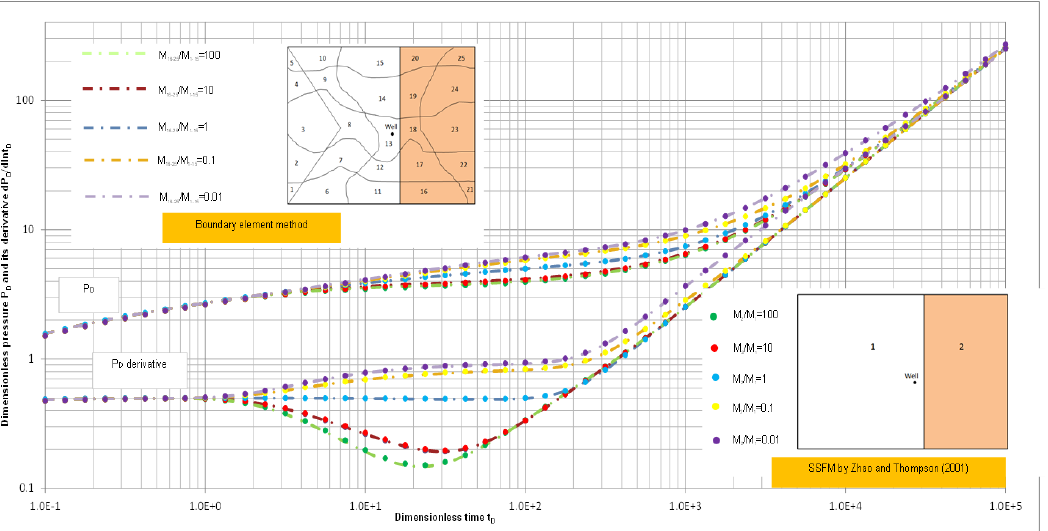
Figure 5. Comparison between solutions generated by this BEM model and Zhao and Thompson’s SSFM semi-analytical model